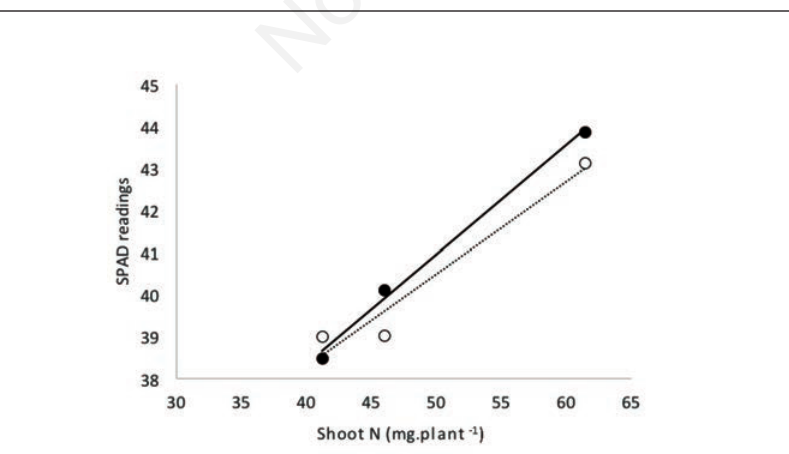
Figure 1. Effects of three commercial substrates (I, forest residues, husks, and peat; II, peat; III, coir) on pH (A), electrical conductivity (B) and concentration of nitrate (C) in the drainage water. Each symbol represents the mean of four replicates, and the error bars represent ±1 standard error.